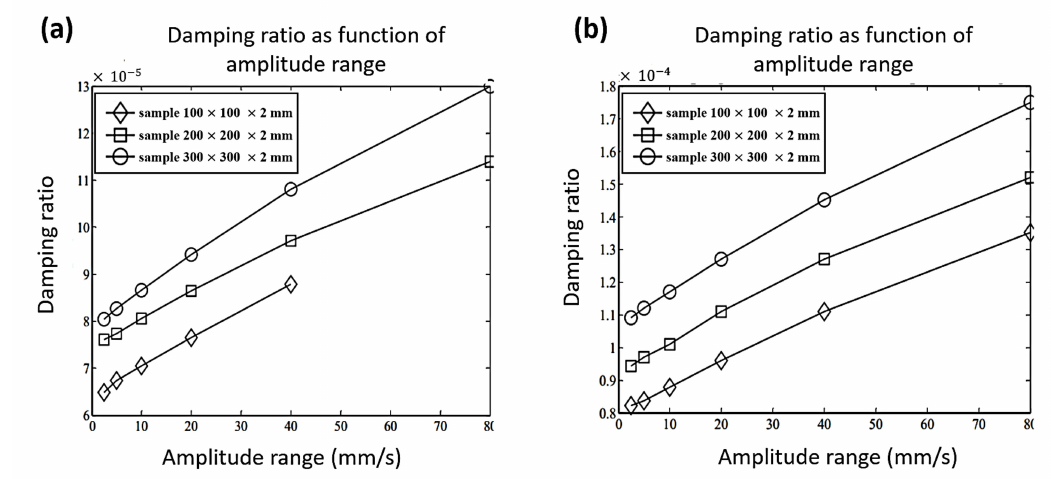
Figure 6. Damping ratio as a function of ( a ) specimen response amplitude (first mode shape); ( b ) specimen response amplitude (second mode shape) for three specimen sizes